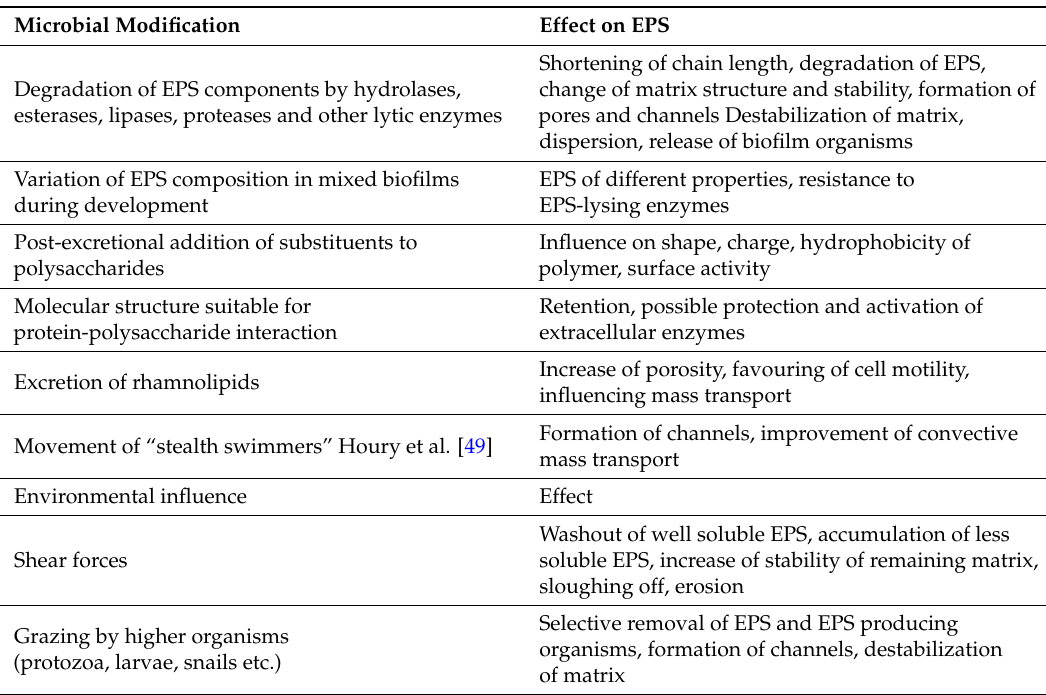
Table 2. Overview of modification of EPS and matrix structure after excretion (after [48], with permission.